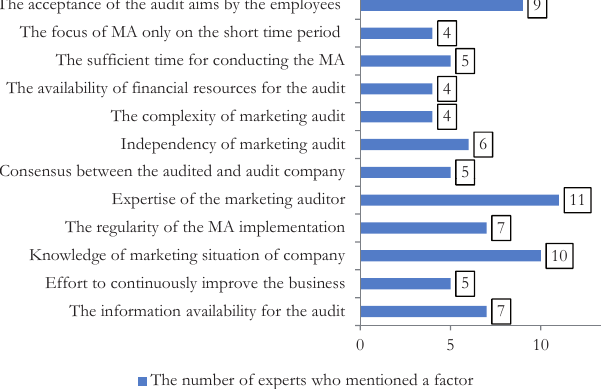
Fig. 1 – Factors influencing the efficiency and the results of marketing audit (from an expert point of view). Source: Own